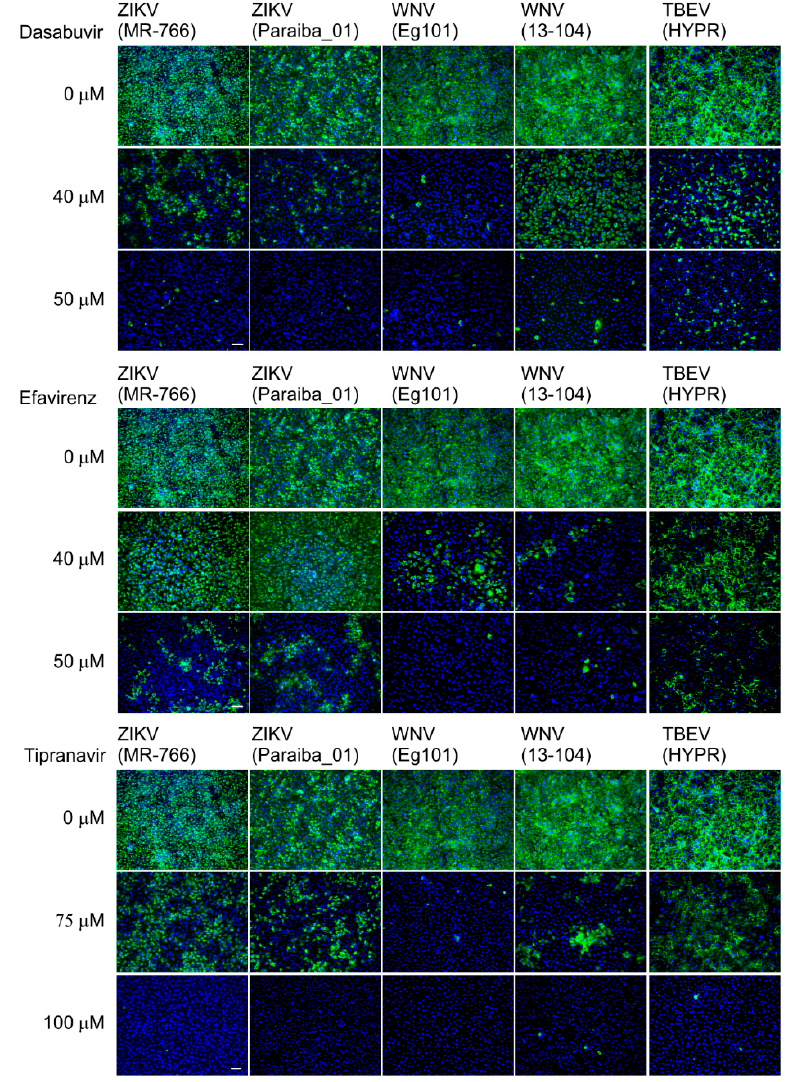
Figure 5. Inhibition of flaviviral surface E antigen expression by efavirenz, tipranavir, and dasabuvir. Virus-infected Vero cells were fixed on slides at 48 h p.i. and stained with flavivirus-specific antibody labeled with fluorescein isothiocyanate (FITC, green) and counterstained with 4 ′ ,6-diamidino-2-phenylindole (DAPI, blue). Scale bar, 50 µm.